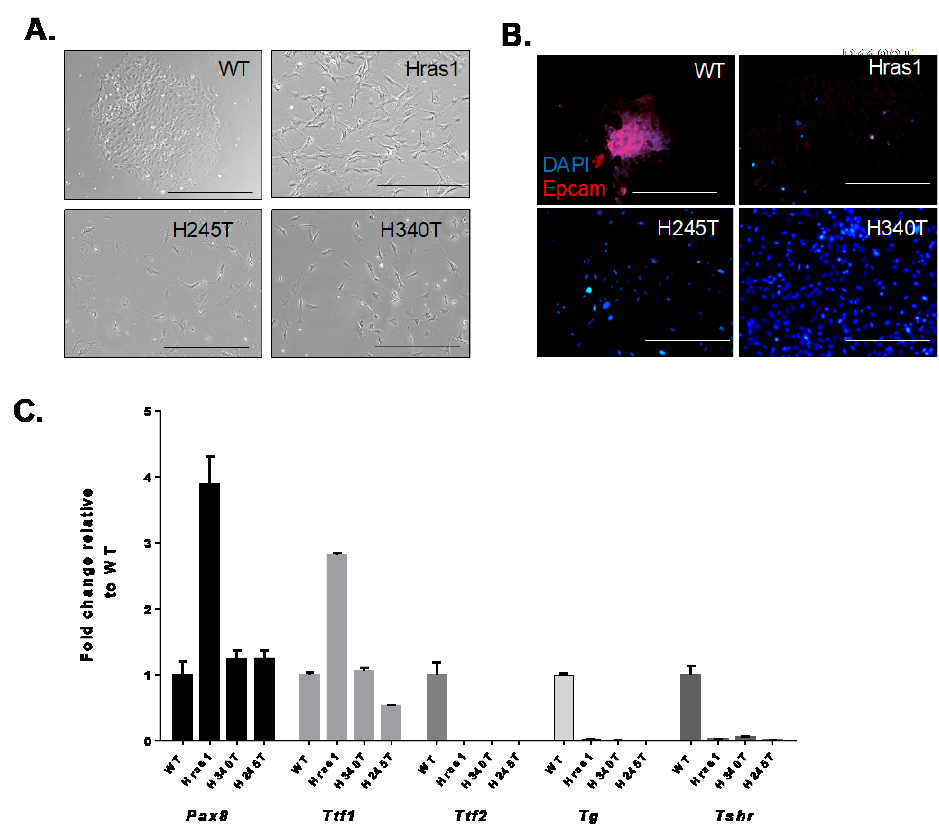
Figure 2. Morphological features and expression of thyroid-specific genes in Hras G12V /Pten −/− /TPO-Cre (Hras1, H245T, and H340T) thyroid tumor cell lines. ( A ) Phase-contrast images (10×) of primary wild-type (WT) thyrocytes and thyroid tumor cell lines in culture. Scale bar represents 400 µm. ( B ) Fluorescent imaging (20×) of EpCAM immunostained WT (positive control) thyrocytes and thyroid tumor cell lines in culture. Scale bar represents 200µm. Nuclei are stained with 4′, 6 -diamidino-2-phenylindole (DAPI). ( C ) Real-time PCR analysis of the expression levels of thyroid-specific genes in primary wild-type (WT) thyrocytes and thyroid tumor cell lines in culture. Data are representative of three independent experiments. Each sample was analyzed in triplicate ( n = 3).